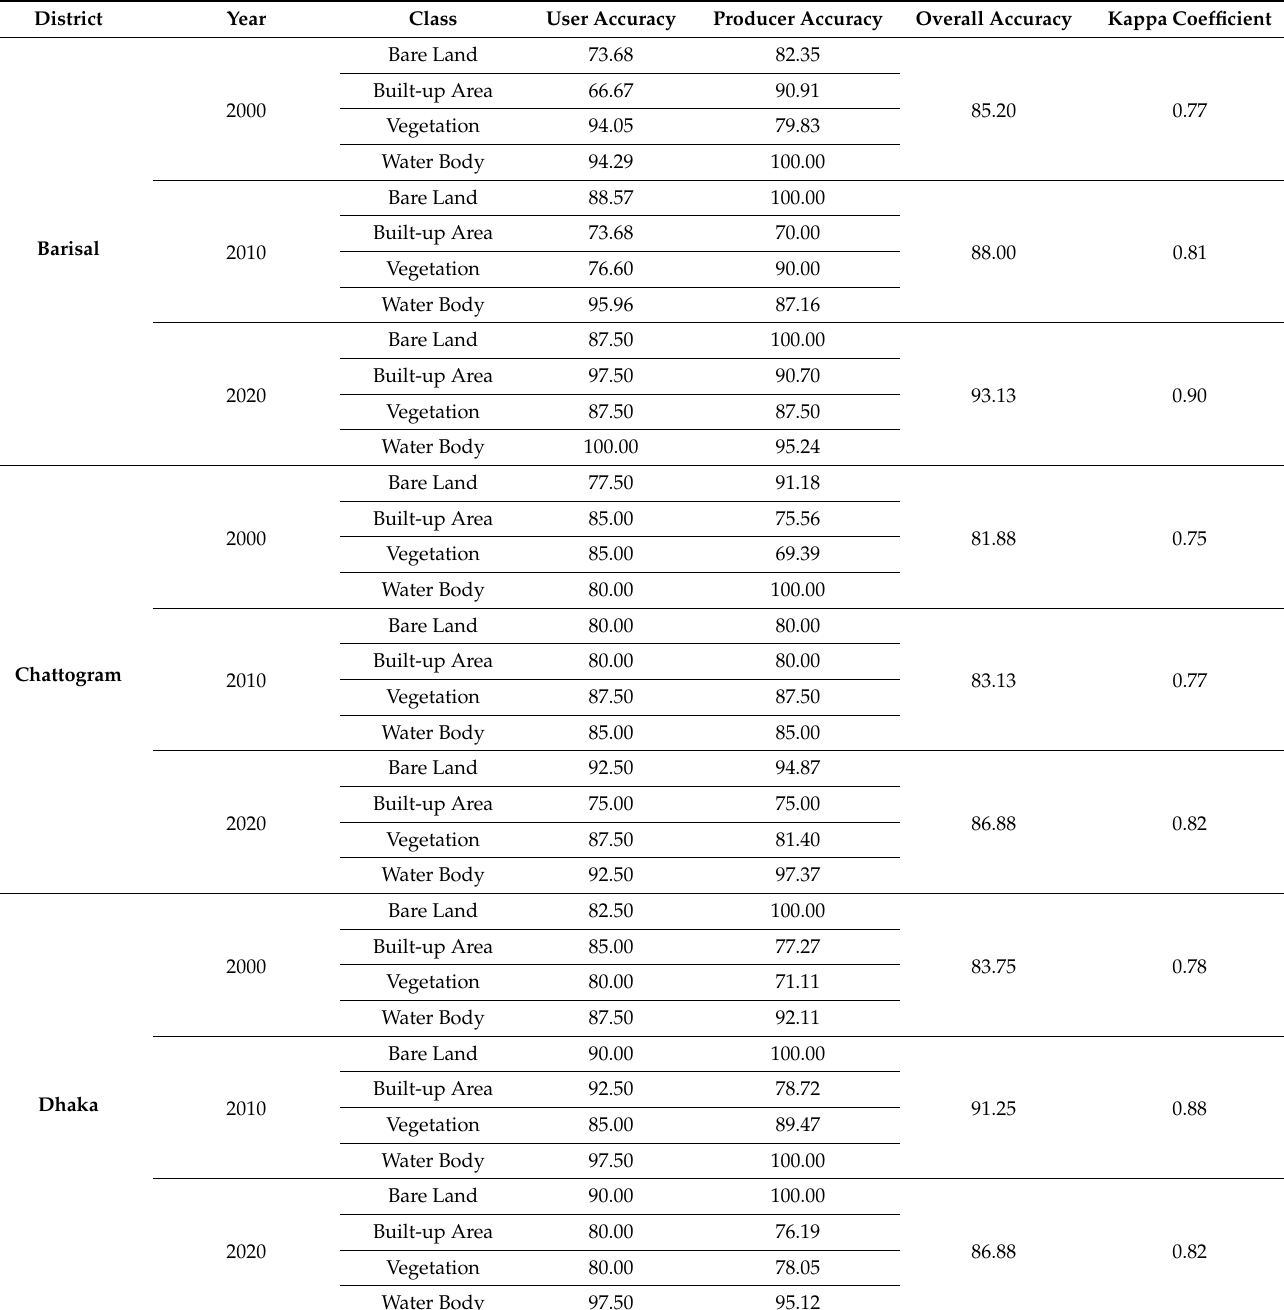
Table 4. Accuracy assessment